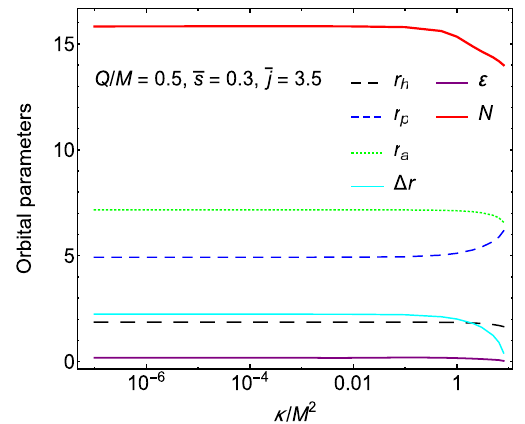
Fig. 3 The shapes of the effective potential V eff for different κ ( a – d ), where the horizontal red lines in potential indicate the particle energy ¯ e = 0 . 9365. The corresponding orbits with respect to the energy